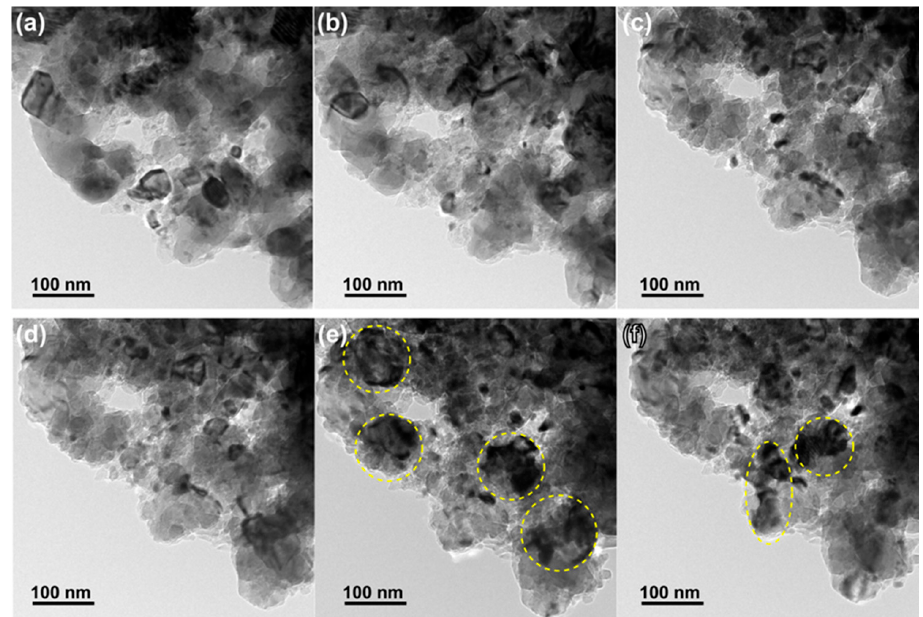
Figure 4. Microstructure evolution as observed by in ‐ situ TEM. Images taken: ( a ) after temperature reached 600 °C under vacuum; ( b , c ) after 5 and 10 min of exposure to the gas mixture, respectively; ( d ) just after evacuation of the gas mixture; ( e , f ) during cooling to room temperature under vacuum. The selected areas indicate coarsened grains during cooling.